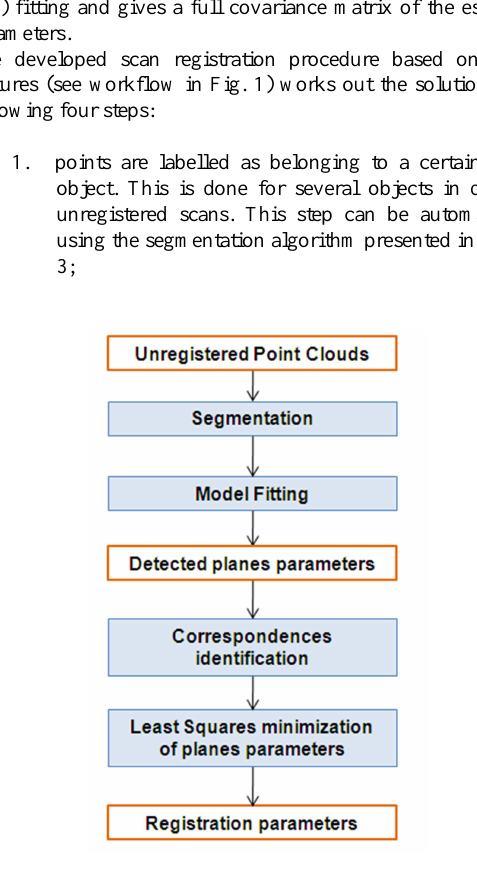
Figure 1. Workflow of the developed method for scan registration with planar